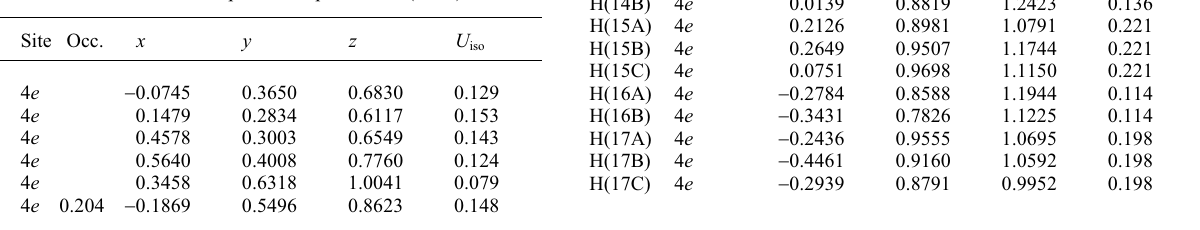
Table 2. Atomic coordinates and displacement parameters (in Å 2 ) .